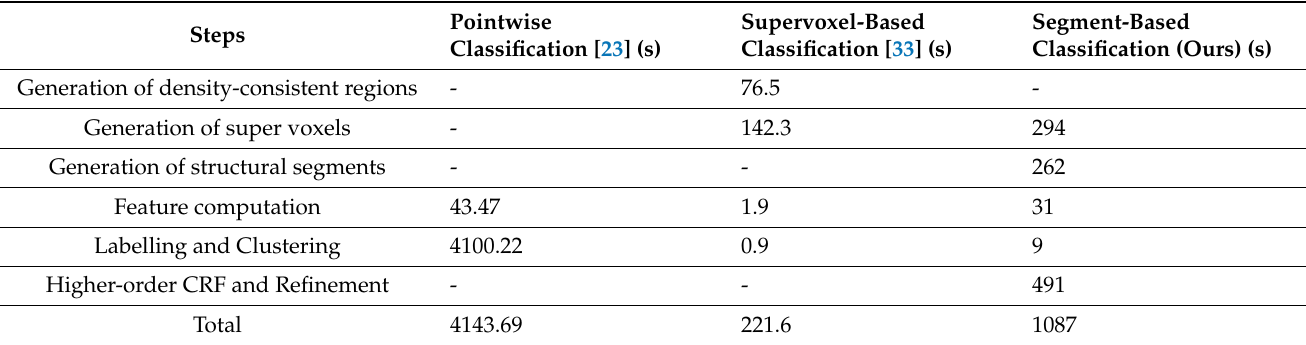
Table 8. Time cost of different classification methods in the Paris-rue-Cassette